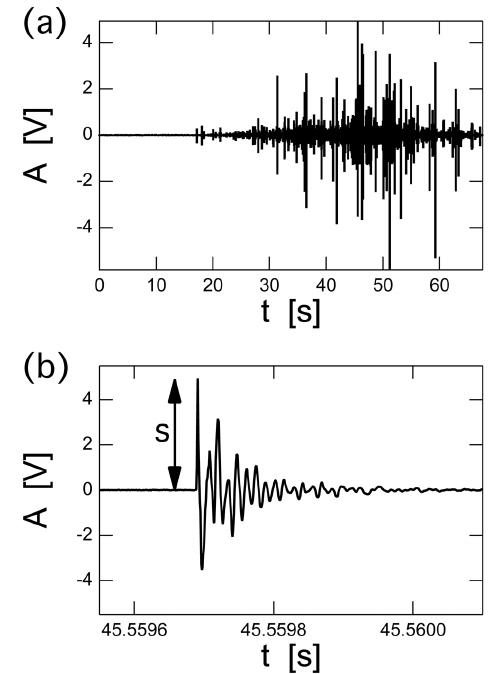
Fig. 3. Raw data example of AE signal. Experimental conditions are d = 0 . 8 mm, r = 10mm, and v = 1 . 0mms − 1 . t = 0 corresponds to z = 0. Whole data during a penetration is shown in (a) , and an example of a single AE event is shown in (b) . Size of AE event s is defined by the maximum